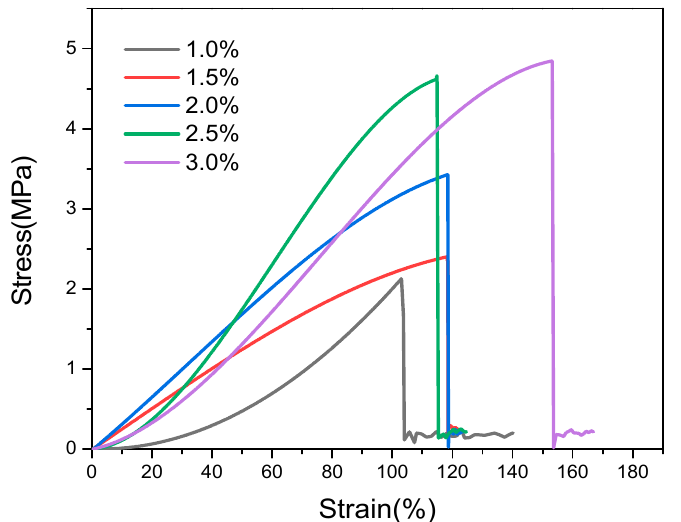
Figure 11. Effect of A-TiO 2 content on the tensile mechanical properties of PU-TiO 2 composite film.